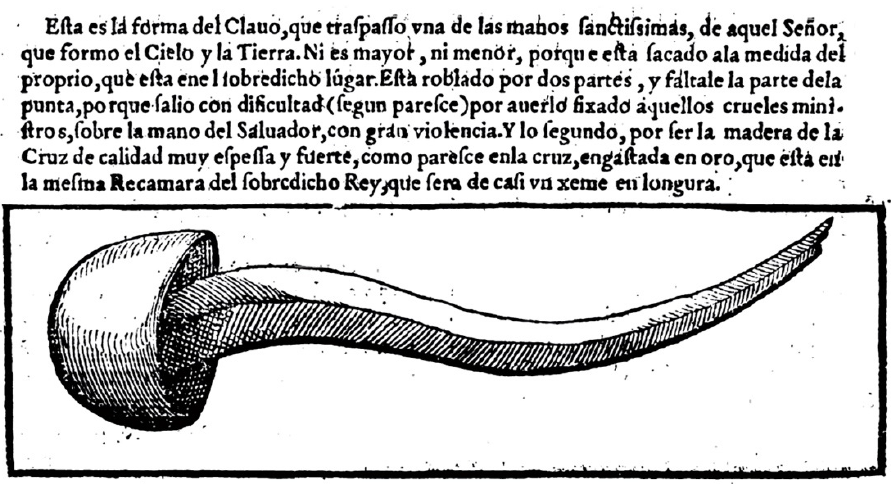
Figure 2. Anonymous. Clavo de una mano de la crucifixión de Cristo . PHILIPPE DE SOSA, Libro de la Primera parte, de la excelencia del Sancto Evangelio …, Third book, p.